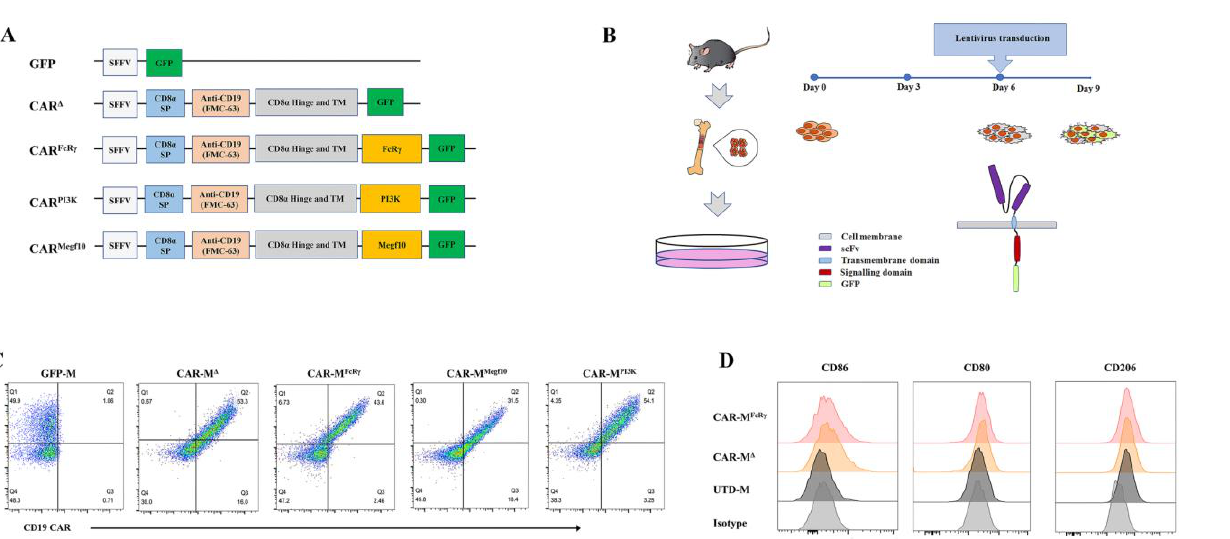
Figure 1. Preparation of CAR-Ms and their CAR expression. ( A ) Schematic representation of lentiviral vectors expressing CAR or GFP control. SP, signal peptide; TM, transmembrane domain. ( B ) Schematic of CAR-M production using lentivirus. ( C ) Flow cy- tometric analysis of GFP and CAR expression in bone marrow derived macrophages (BMDM). Data are representative of three inde- pendent experiments. ( D ) Flow cytometric analysis of macrophage polarization M1 and M2 surface markers (CD86, CD80, CD206). UTD-M, untransduced macrophage. Data are representative of three independent